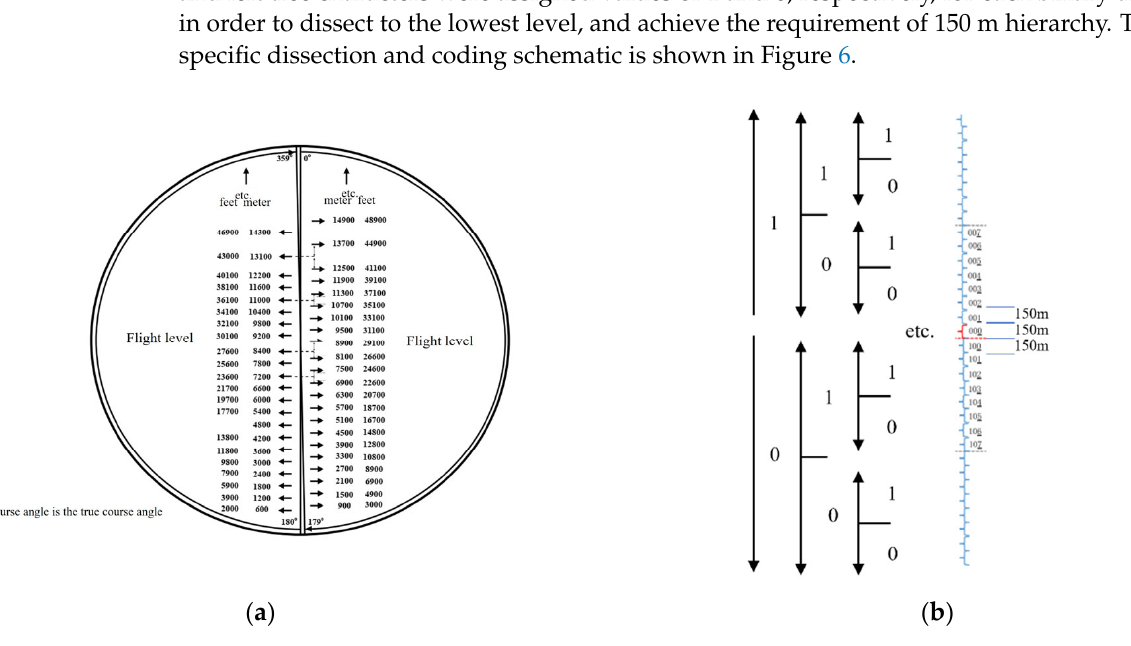
Figure 6. Height division and coding method: ( a ) flight height level division; ( b ) binary tree encoding structure of height.